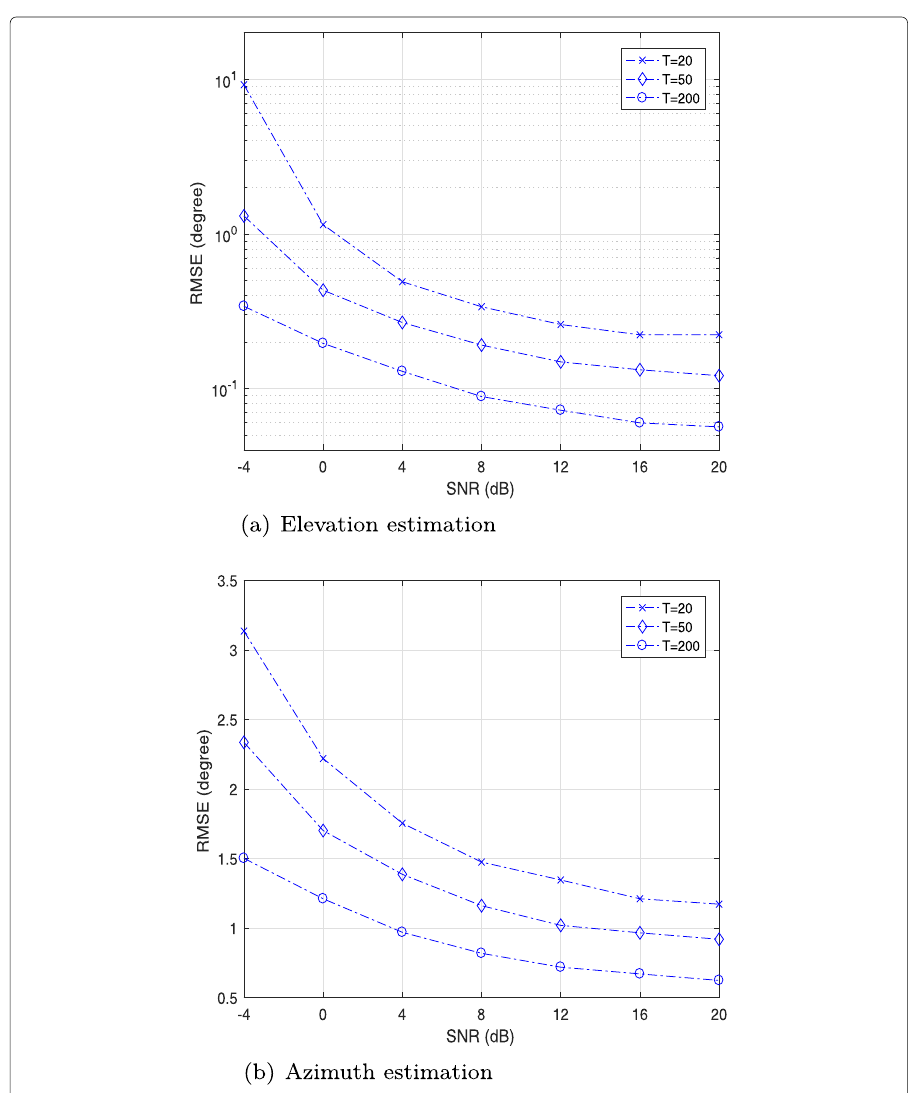
Fig. 5 DOA estimation performance analysis of SLS-VCPD method versus SNR with different number of samples. A nested EMVS array is equipped with M = 6 sensors. The number of sources is set as K = 2